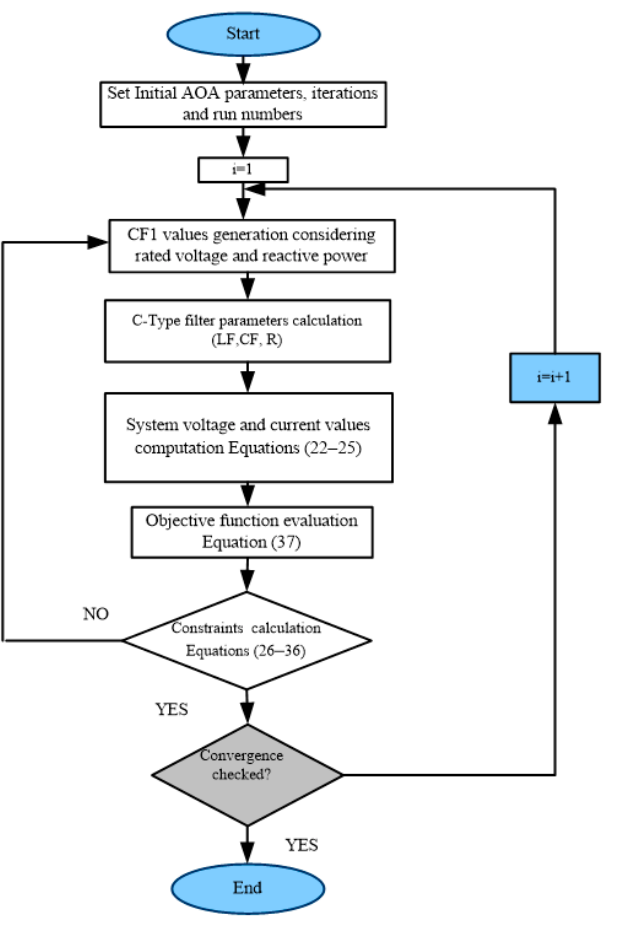
Figure 5. The schematic diagram of the proposed technique.